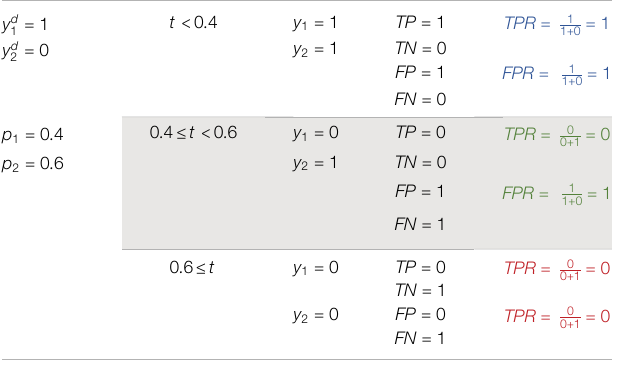
TABLE 3 | Example 2.